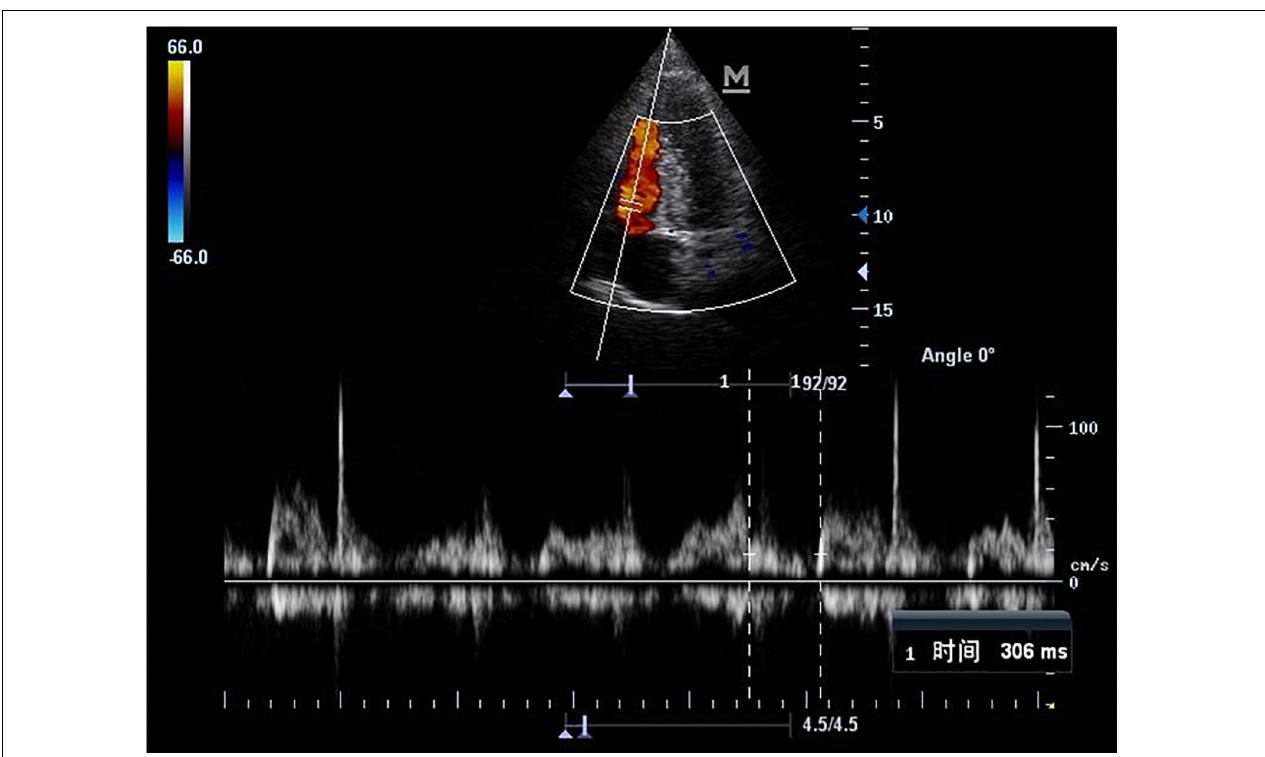
FIGURE 5 | The blood flow spectrum of tricuspid valve in patient with clinical brain death.